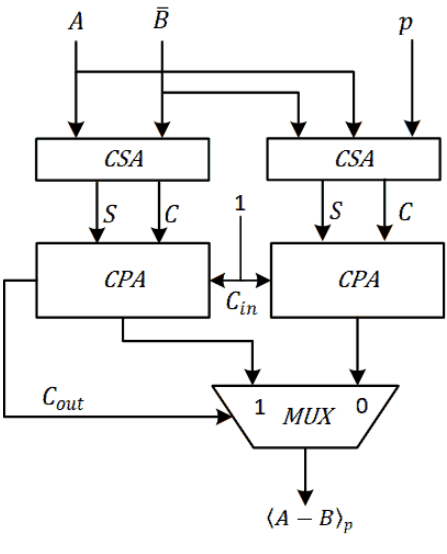
Figure 8. Hardware implementation of modular subtraction ( A − B mod p ).